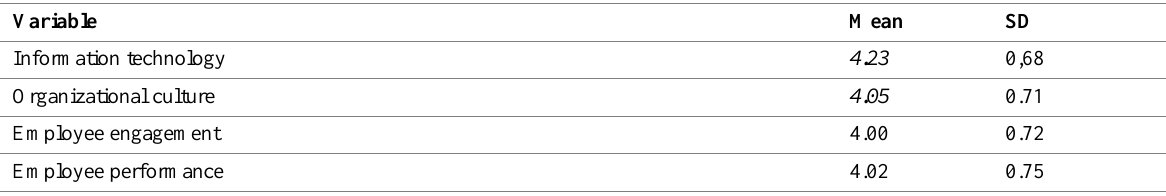
Table 2 : Descriptive Statistic and